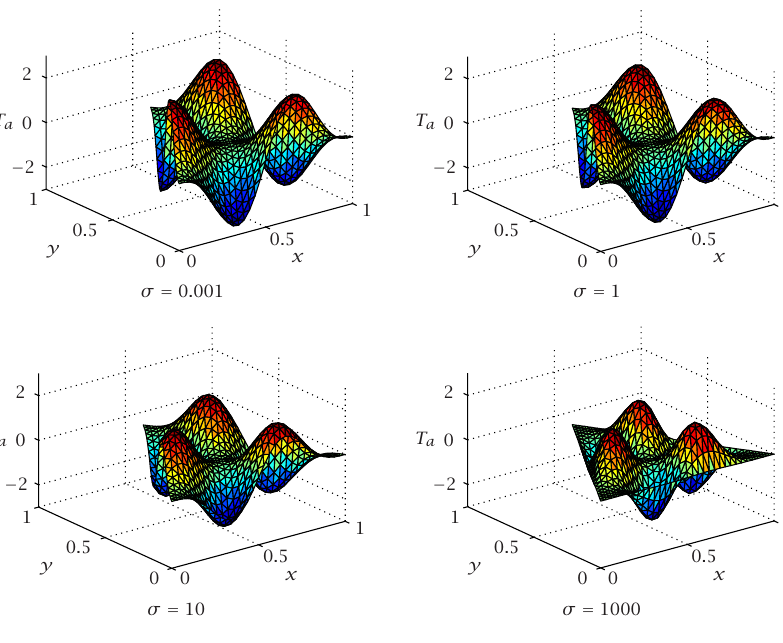
Figure 7.7 . The ( 0 , 3 ) antisymmetric